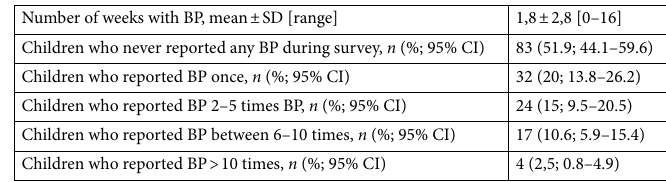
Table 3. Proportion of children reporting BP during the study period among responders ( n = 160).